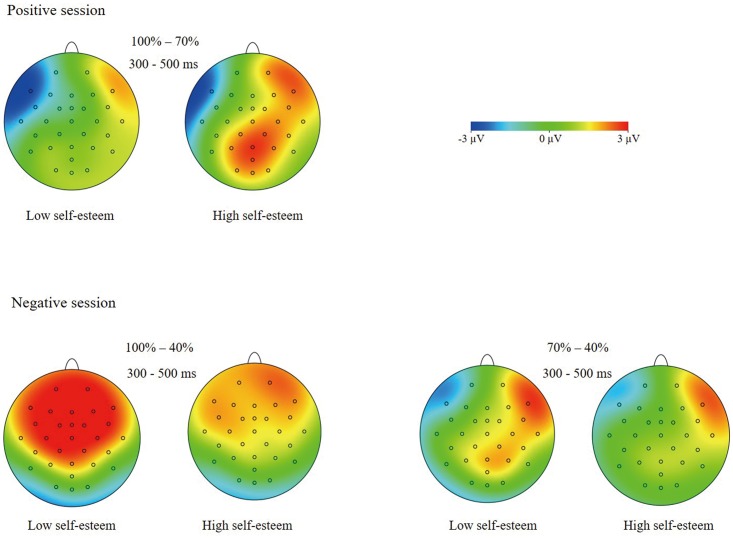
(Top) Topographical maps of the amplitudes difference between 100% and 70% happy faces (across 300–500 ms) in high and low self-esteem participants. (Bottom) Topographical maps of the amplitudes difference between 100% and 40% anger faces (across 300–500 ms), and between 70% and 40% anger faces (across 300–500 ms) in high and low self-esteem participants.